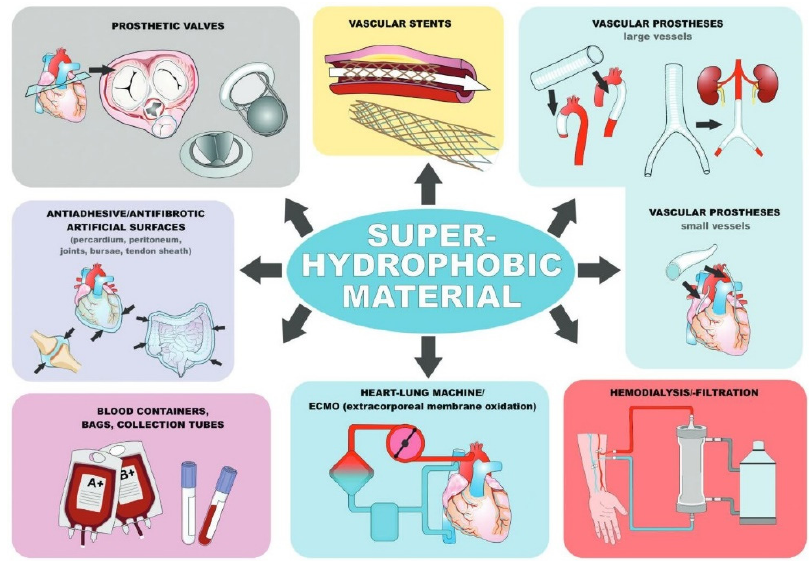
Figure 11. Coatings utilized as blood-repellent surfaces for medical devices [178].